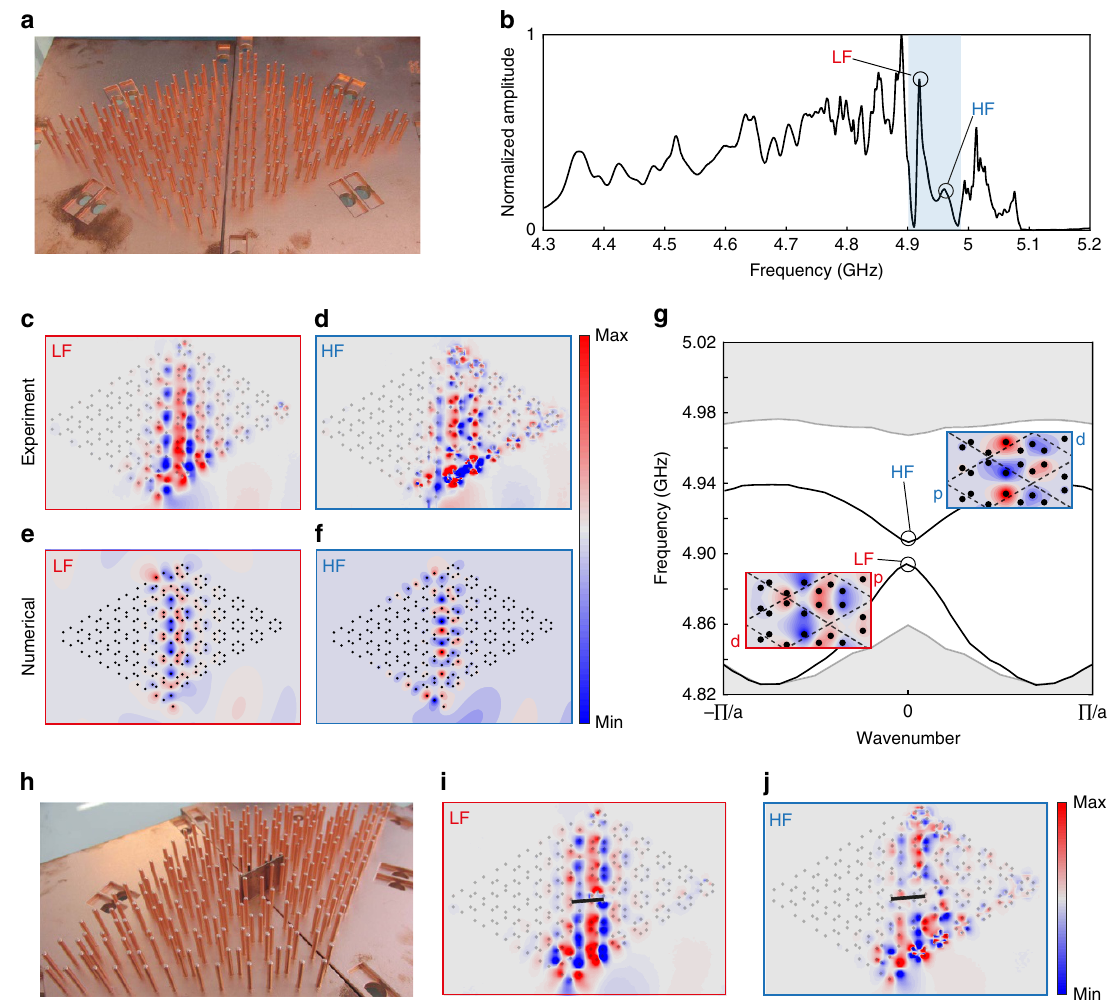
Figure 4 | Experimental observation of topological edge modes guided at the subwavelength scale. ( a ) We form a boundary between the topologically trivial sample and the topologically nontrivial one. ( b ) Spectrum of the field amplitude measured in the sample, averaged along the boundary. Two peaks appear in the band gap corresponding to a low frequency (LF) and a high frequency edge mode (HF). ( c , d ) Experimental electric field maps for the LF and HF edge modes. ( e , f ) Corresponding field maps computed from a coupled-dipole semi-analytical model. ( g ) Corresponding dispersion diagram for the edge modes, shown in inserts. ( h ) We insert a defect in the form of a large conducting wall placed right on the boundary. ( i , j ) Measured electric field maps in the presence of a defect, showing good robustness of the edge modes despite the breaking of sixfold rotational symmetry along the